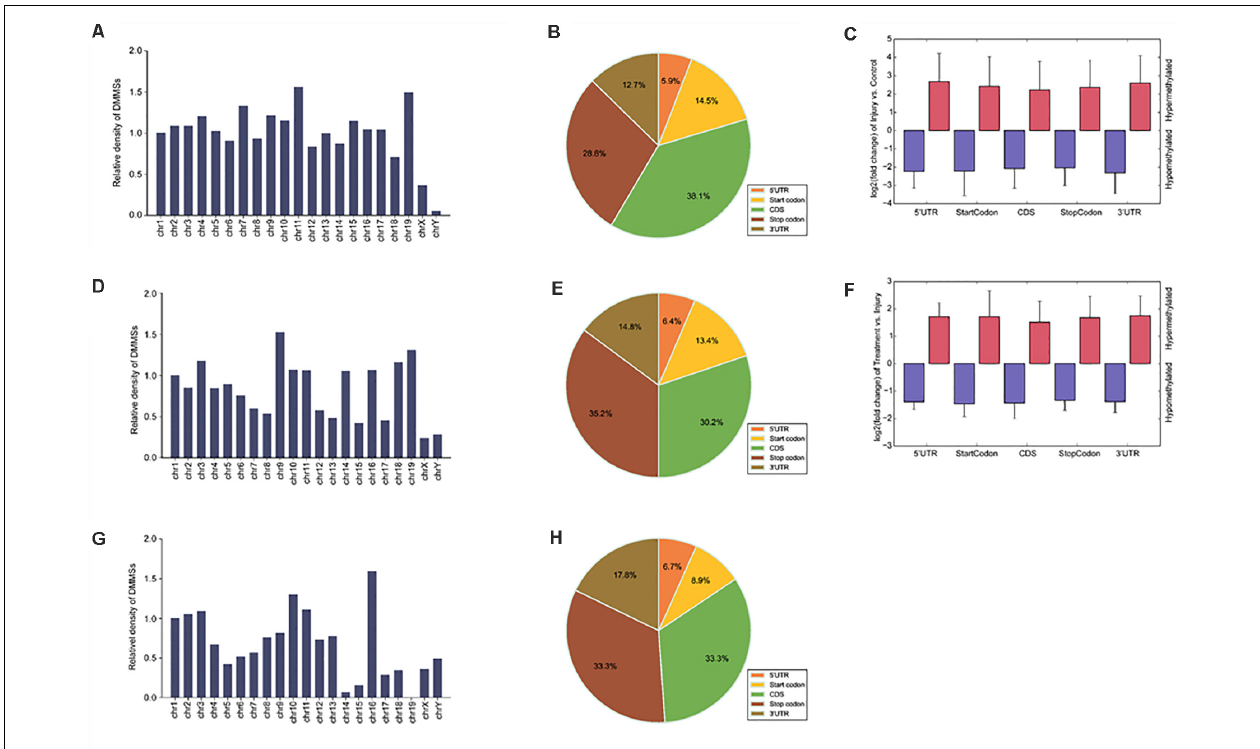
FIGURE 3 | Distribution of differentially methylated N6-methyladenosine sites. (A) Relative occupancy of differentially methylated m6A sites in each chromosome normalized by length in IvC. (B) Pie chart showing the percentage of DMM peaks in five non-overlapping segments in IvC. (C) Statistics of fold change of DMM peaks in five segments. The histogram shows the mean of the fold change in IvC. Error bars represent the standard error of the mean. (D) Relative occupancy of differentially methylated m6A sites in each chromosome normalized by length in TvI. (E) Pie chart showing the percentage of DMM peaks in five non-overlapping segments in TvI. (F) Statistics of fold change of DMM peaks in five segments. The histogram shows the mean of the fold change in TvI. Error bars represent the standard error of the mean. (G) Relative occupancy of differentially methylated m6A sites in each chromosome normalized by length. (H) Pie chart showing the percentage of DMM peaks in five non-overlapping